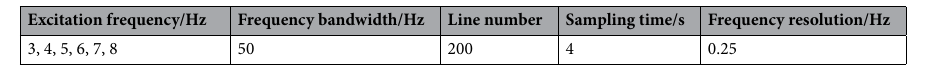
Table 3. Parameter settings of FFT